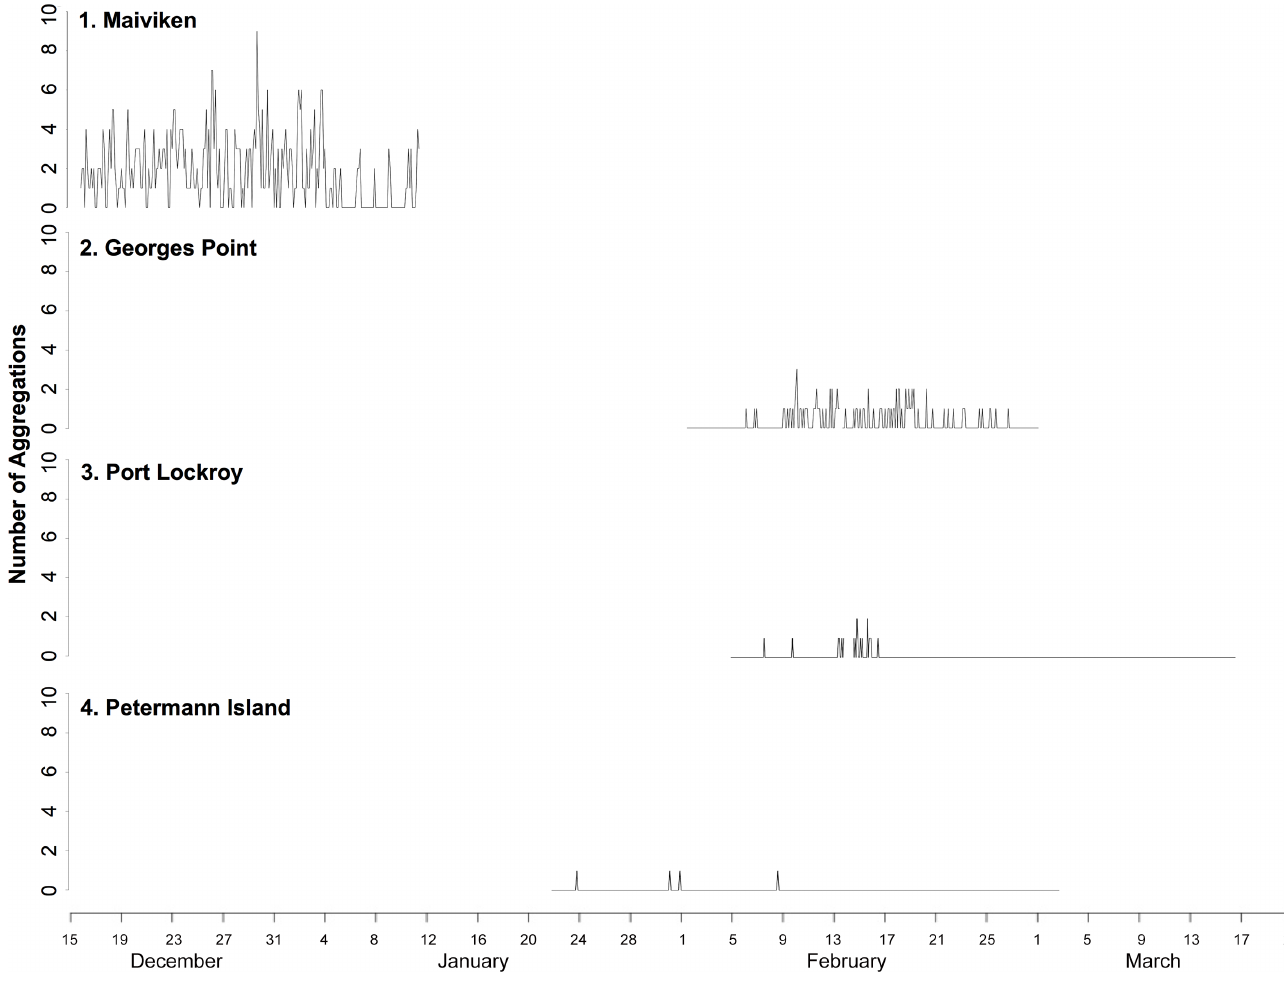
Fig 2. Time series demonstrating difference in the timing of the post-guard period and the number of aggregations over time at four sites: 1) Maiviken, 2) Georges Point, 3) Port Lockroy, and 4) Petermann